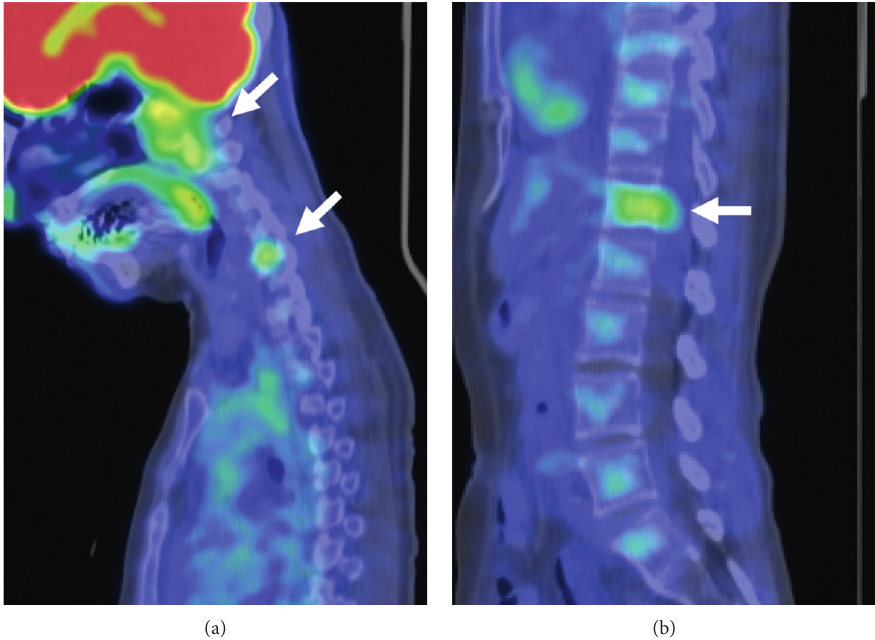
Figure 2: 18 F-FDG-PET/CT scan at first presentation. 18 FDG uptake in (a) skull base and C6 and (b)